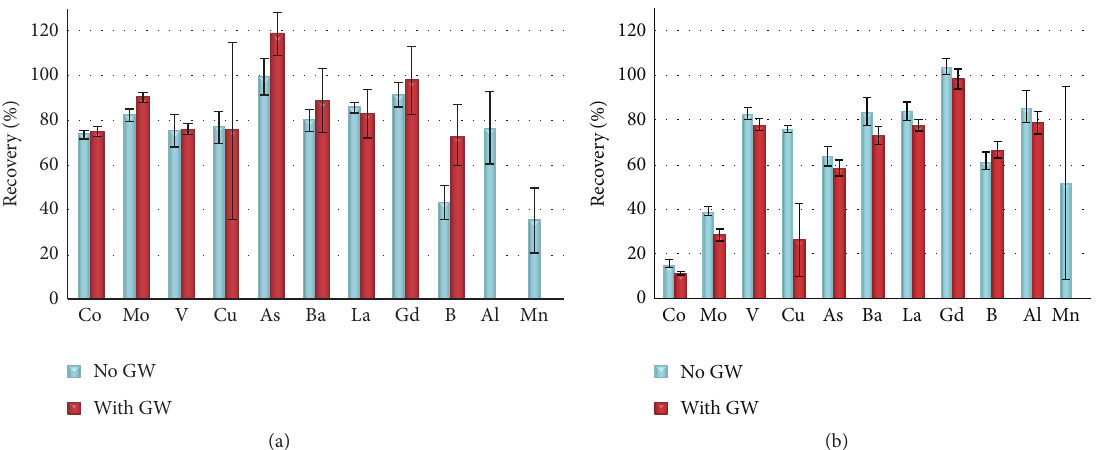
Figure 1: Percent recovery of certified value for NIST 2483 with (a) microwave digestion (MD) and (b) ultrasonic digestion (UD) methods with and without GhostWipes. The results are presented as mean (%) and standard deviation of five independent